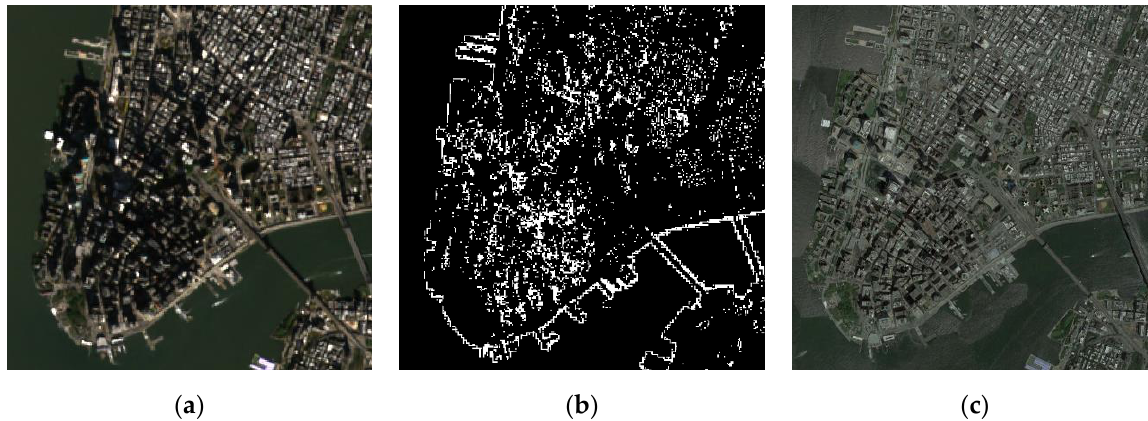
Figure 2. ( a ) True-color (red–green–blue) composite of Sentinel-2 image; ( b ) pixels that were both identified as soil and water in ( a ); ( c ) true-color (red–green–blue) composite of Google Earth image. Note that all the images in this figure are zoomed to be the same size for an easy comparison.